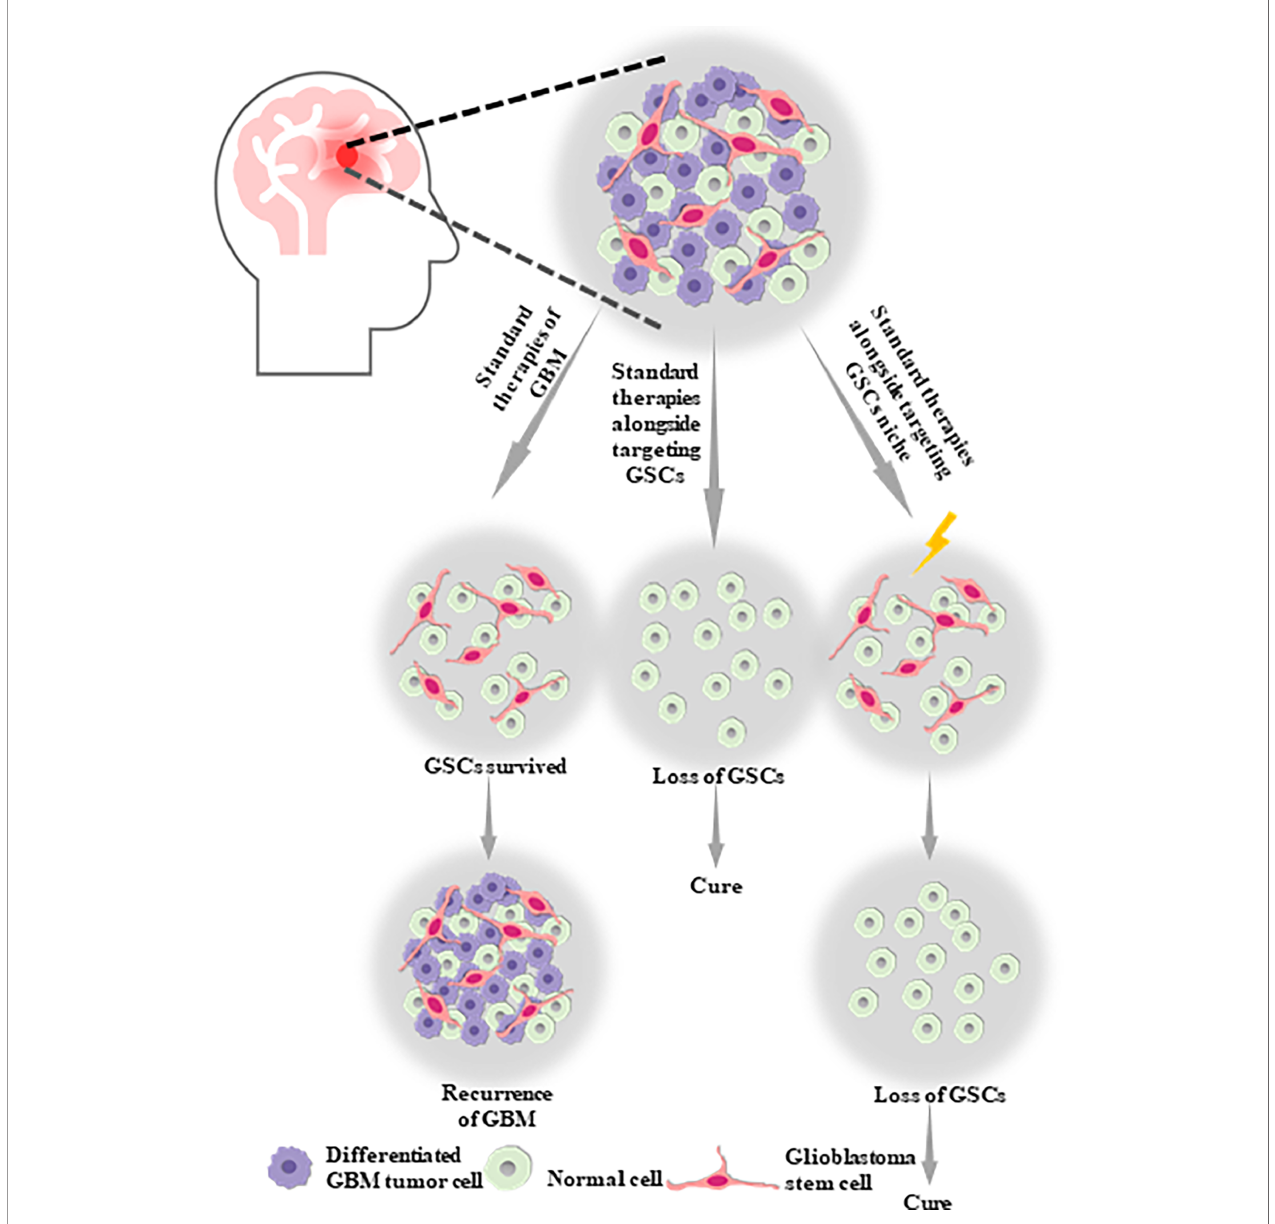
FIGURE 1 | Glioblastoma stem cells (GSCs) are likely to be one of the potential causes of tumor proliferation, maintenance, malignant recurrence and metastasis in GBM, which aid in the self-renew, multilineage differentiation and proliferation of GSCs. Therefore, standard therapies alongside targeting GSCs or targeting GSCs niche might be the optimal therapy strategy for